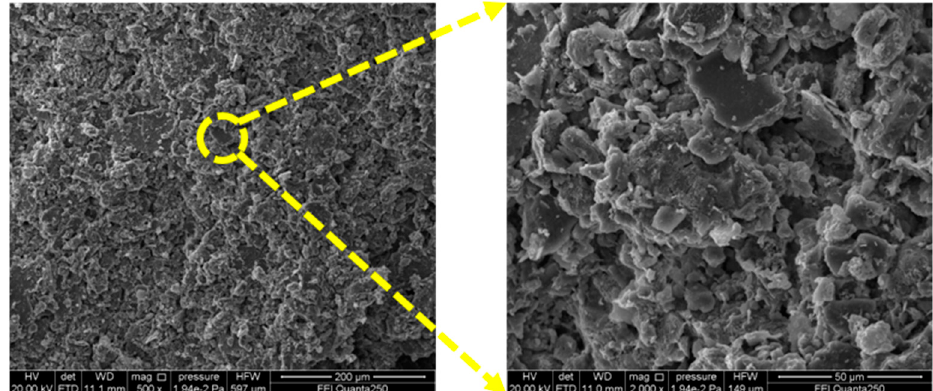
Table 2. Parameters of the grey bricks.